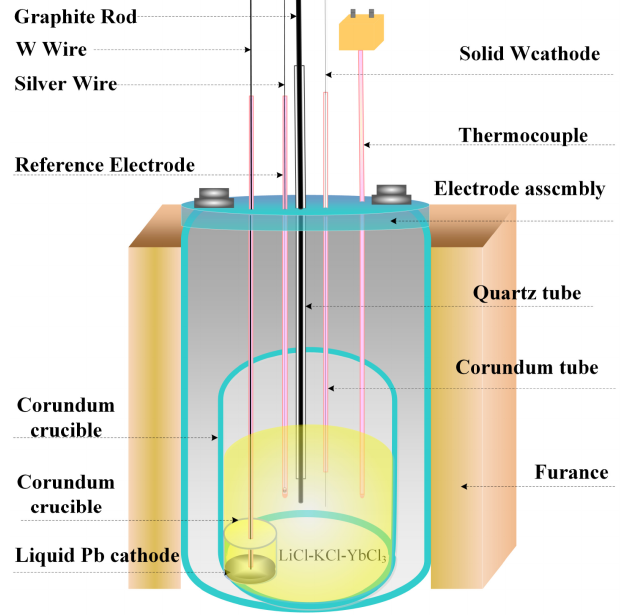
Figure 2. The schematic setup of three-electrode electrochemical cells inside the furnace.